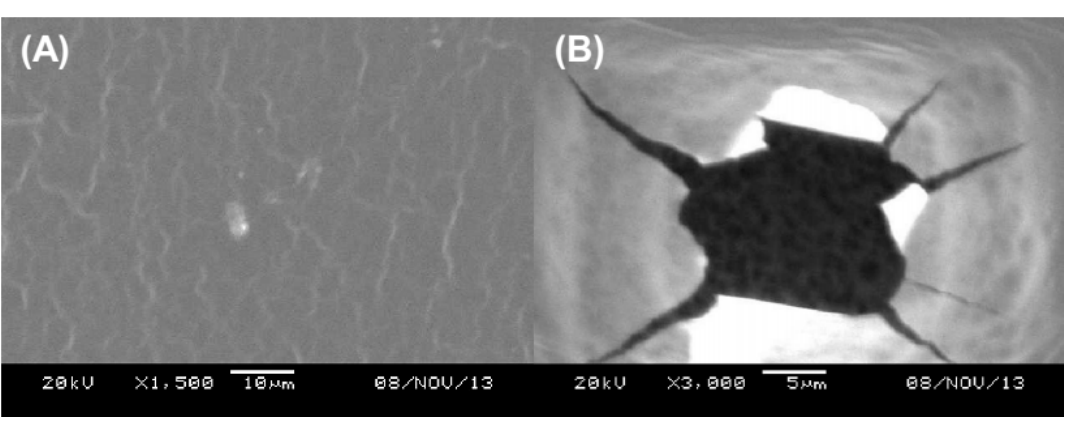
Figure 6. Leishmanicidal activity of the PVA–H and the PVA–AmB against ( A ) Leishmania amazonensis and ( B ) Leishmania braziliensis.